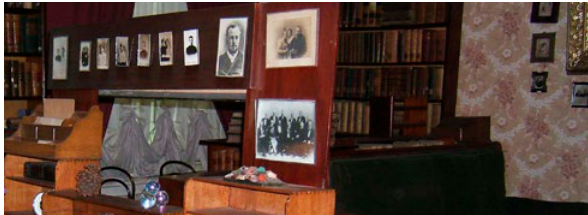
Figure 2. Mendeleev photographs and memorabilia. Photograph courtesy of Roger